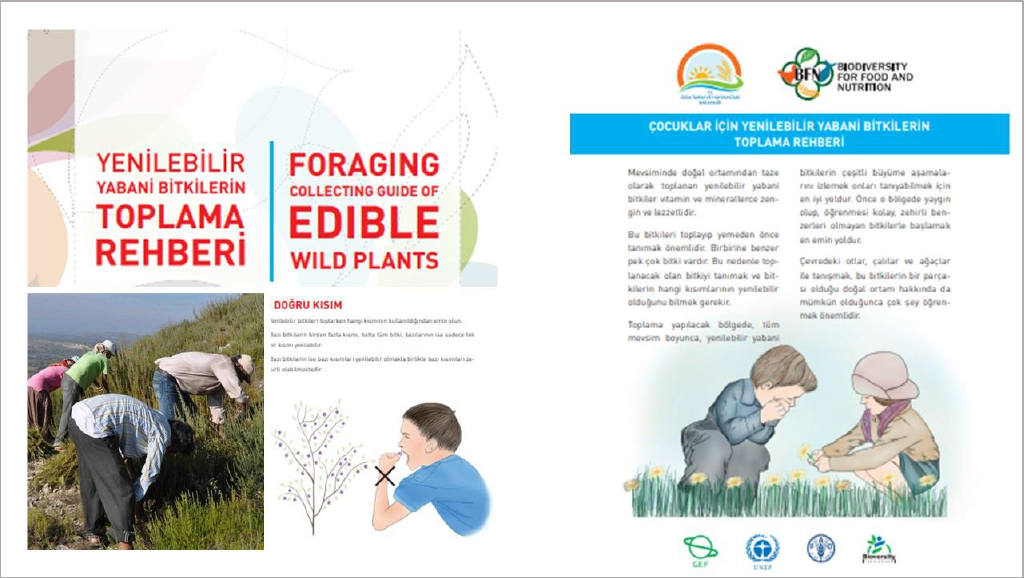
Figure 9. Foragers’ guide to edible wild plants and illustrations taken from “A children’s guide to the collection of wild edibles”, produced by BFN Turkey to complement activities aimed at raising the profile of Turkish WFPs. Credit: BFN Turkey.